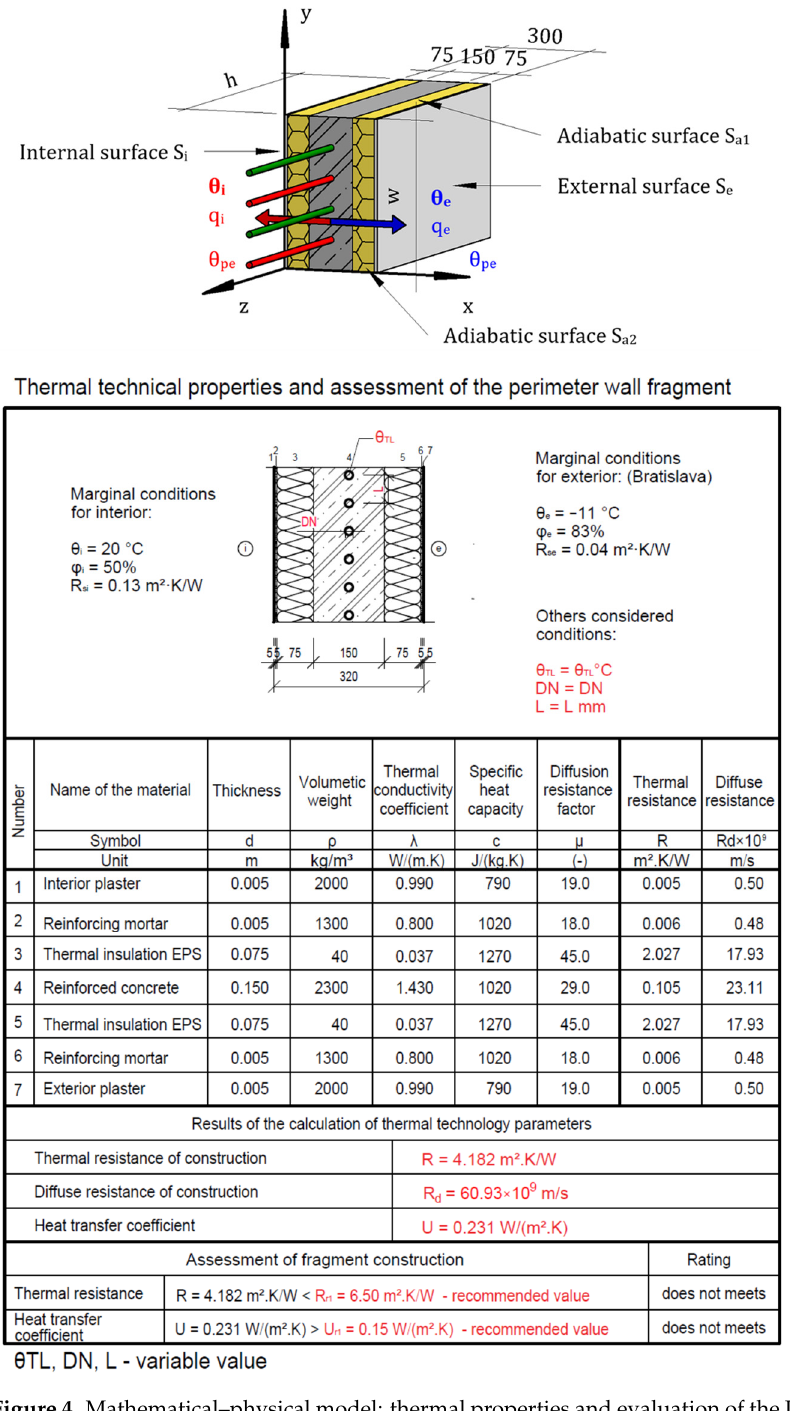
Figure 4. Mathematical–physical model: thermal properties and evaluation of the ISOMAX perim-